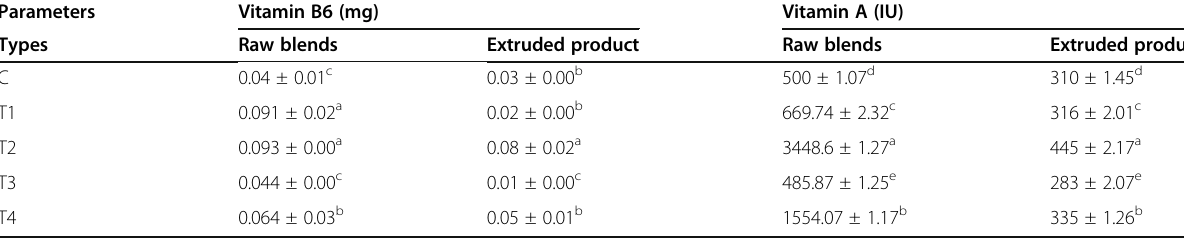
Table 5 Vitamin estimation of raw blends and extruded products per 100 g Parameters